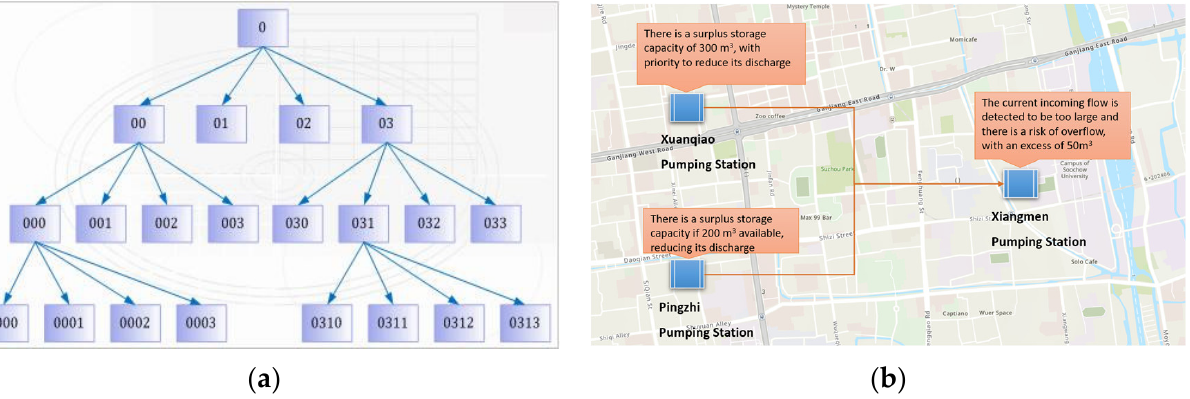
Figure 6. Schematic diagram of the control logic of a step-pumping station. ( a ) Schematic diagram of the multinomial tree model for a stepped pumping station. ( b ) Schematic diagram of the regional linkage control of three pumping stations in two grades.